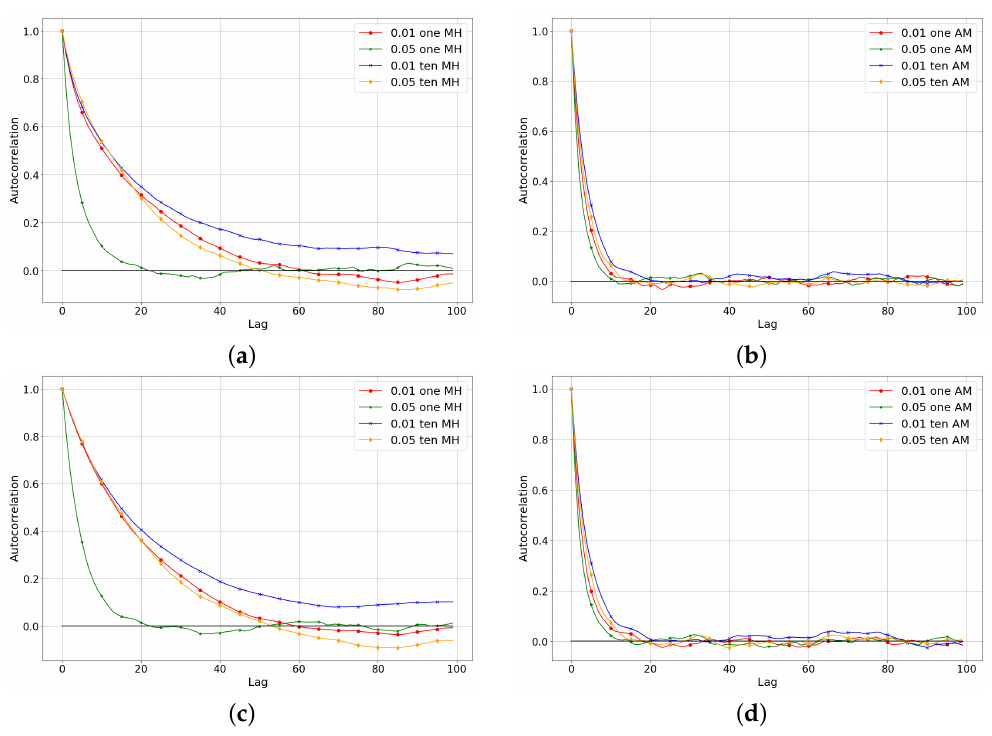
Figure 5. On the first row ( a , b ) autocorrelation functions for Da a variable, on the second row ( c , d ) autocorrelation function for Da d variable. The first column ( a , c ) shows the MH algorithm, the second column ( b , d ) shows the AM algorithm.